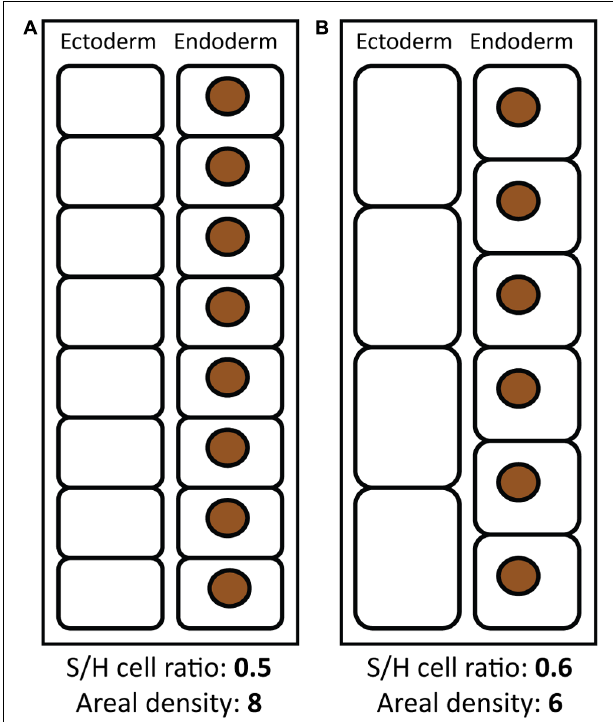
FIGURE 1 | Coral tissue architecture and different metrics of symbiont abundance. Two scenarios of coral and symbiont tissue architecture are shown, theoretically representing coral tissues in winter (A) and summer (B) , with corresponding values of the symbiont to host cell ratio and areal symbiont density. Black rounded rectangles represent coral host cells (comprising ectoderm and endoderm tissue layers) and brown circles represent symbiont cells. Areal symbiont density is higher in (A) , while the symbiont to host cell ratio is higher in (B) , showing how these metrics may change in opposite ways depending on tissue architecture. Schematics are not to scale and are meant to illustrate conceptual differences between different